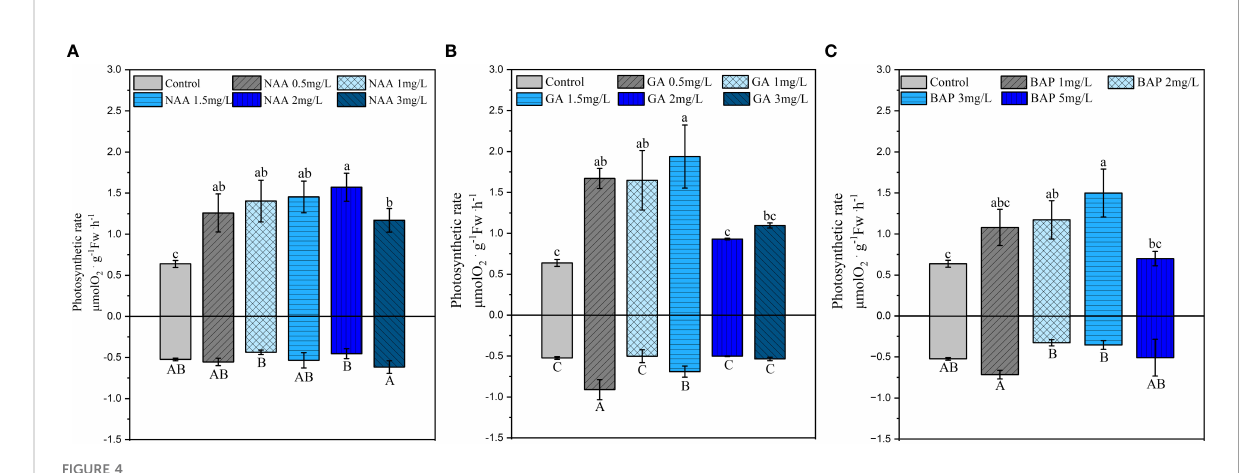
FIGURE 4 Effects of three exogenous hormones on the maximum net photosynthetic rate (Pm) and dark respiration rate (Rd) in Sargassum fusiforme holdfasts (A, B) . Values are the mean ± standard deviation (n = 3). Different letters indicate signi fi cant differences between different culture conditions (p < 0.05).